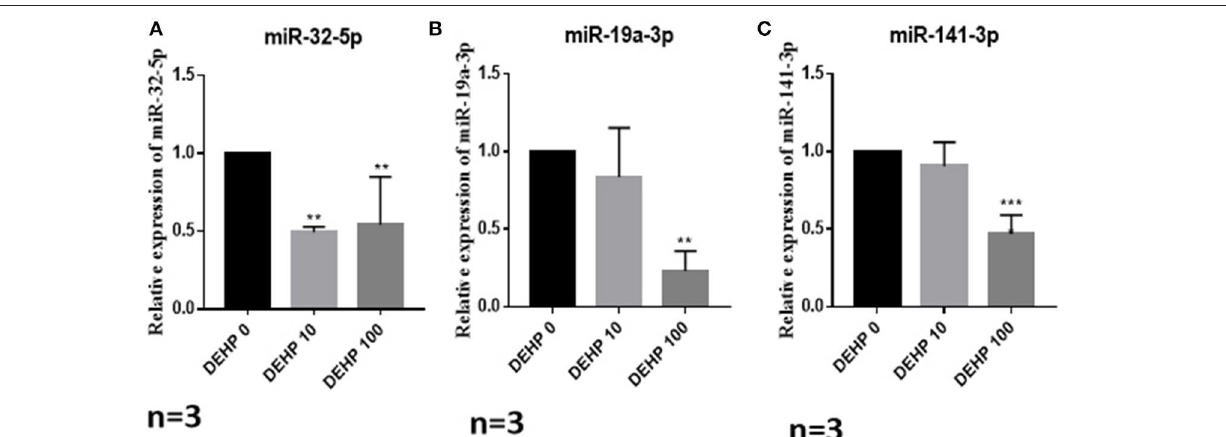
Frontiers in Endocrinology |